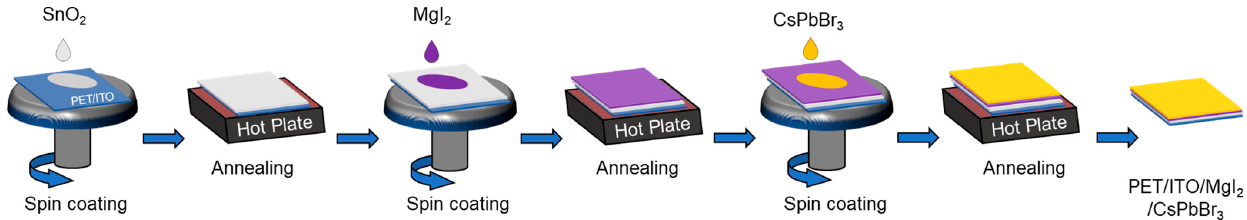
Figure 1. Fabrication procedure of the CsPbBr 3 perovskite thin film.